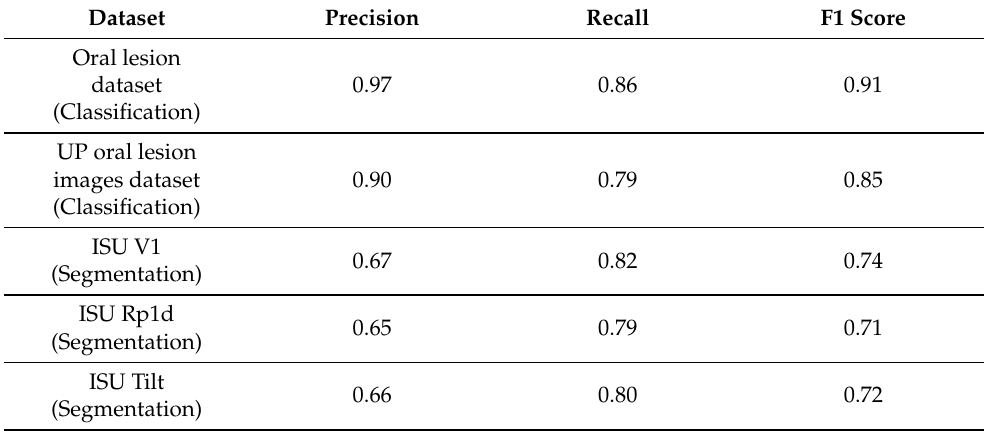
Table 7. The precision, recall and F1 score values of the SPHH when applied to the image process- ing